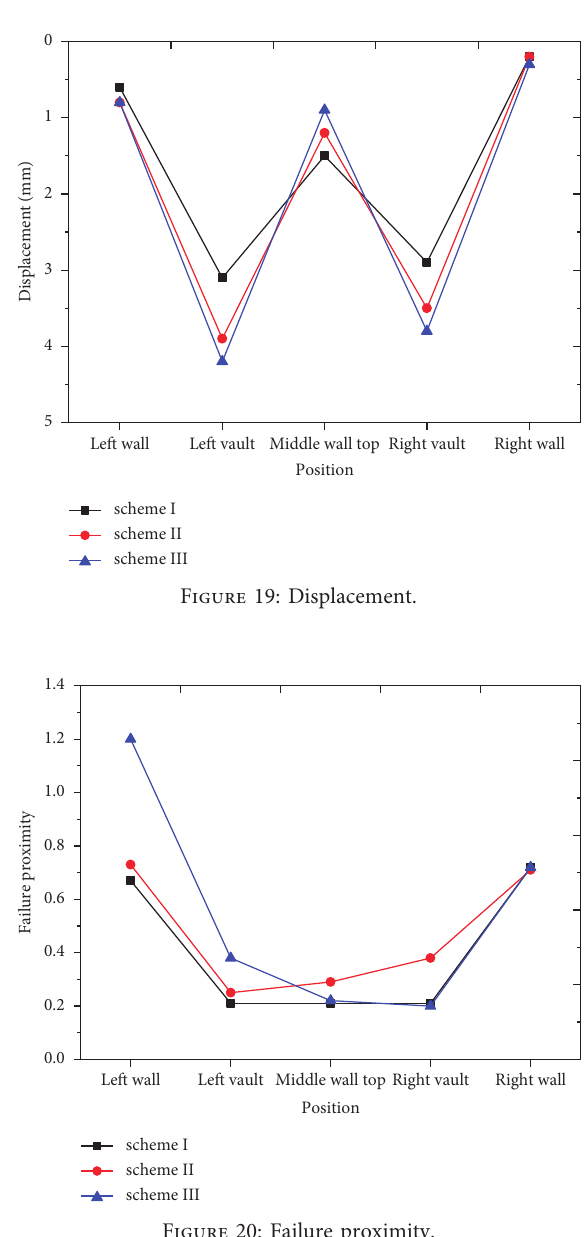
Figure 20: Failure